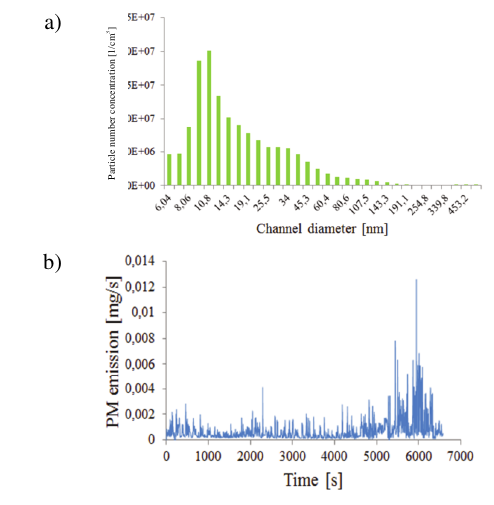
Fig. 12. Solid components of exhaust gases: a) particle number concentra- tion, b) particle mass Table 6. Specific distance emissions results during an extra-urban cycle Specific distance emission during a mo- torway